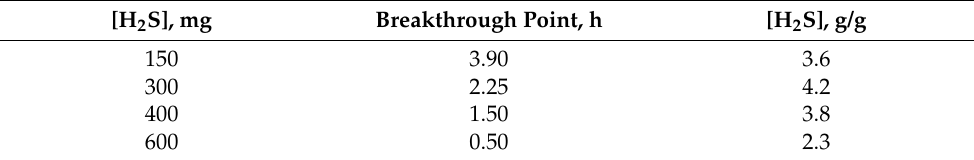
Table 3. H 2 S loading at the breakthrough point at various gas